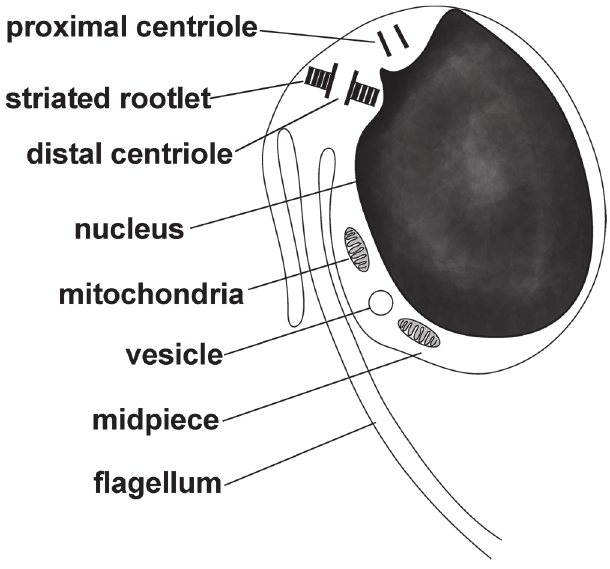
Fig. 5. Schematic representation of spermatozoa of Lebiasina and Piabucina . Both spermatozoa are very similar and share primarily the lateral nucleus, superolateral centriolar complex, striated rootlets, oblong mitochondria and some vesicles in the